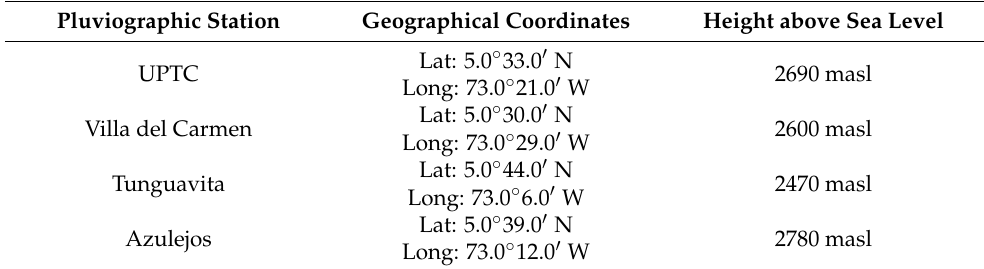
Figure 1. Location of the study area. Table 3. Intensity (mm/h) of the precipitation for two years at different